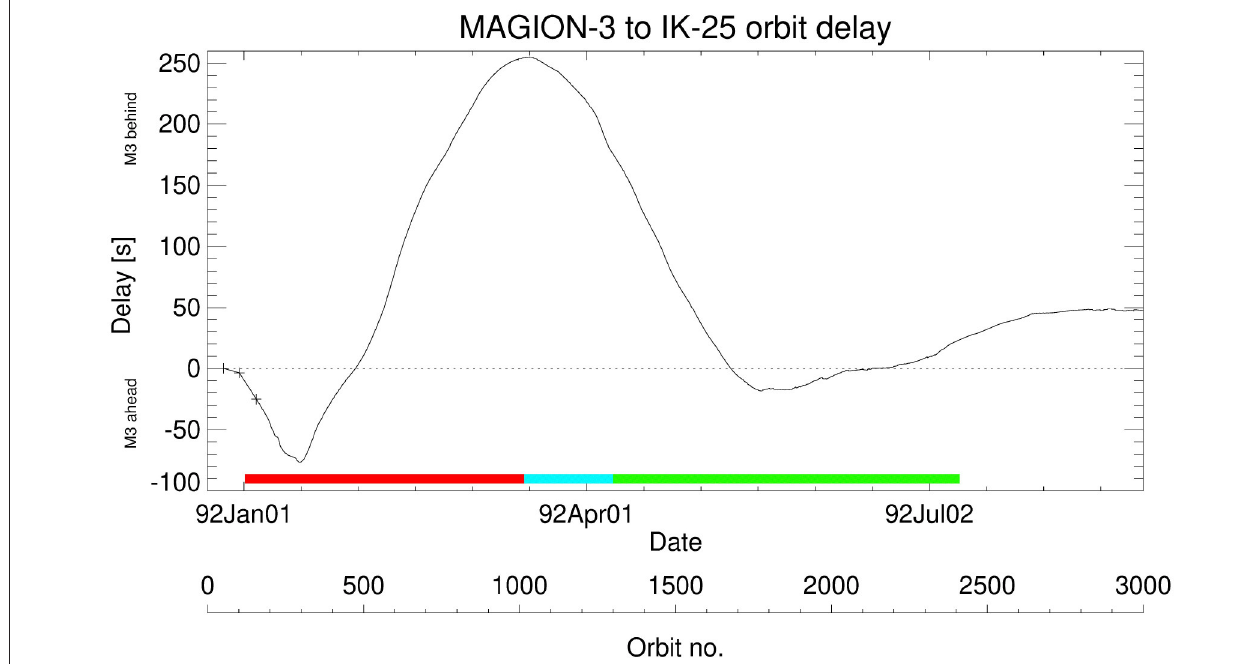
FIGURE 2 | MAGION–3 to IK–25 in-orbit delay. The delay absolute minimum corresponds to ∼ 580 km distance ahead, the absolute maximum to ∼ 1,900 km distance behind. The red bar denotes the season where both UEM and UPM injections were performed, later only the experiments with the UPM injector were done—blue with xenon plasma, green— neutral xenon releases